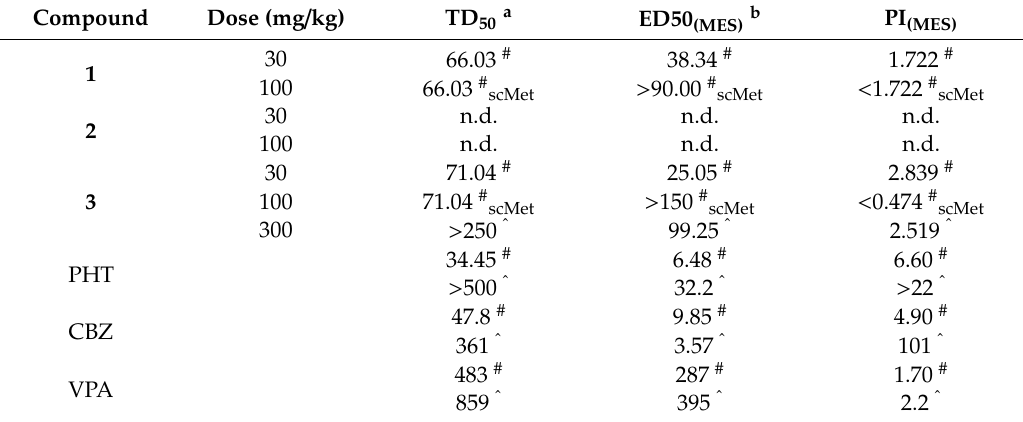
Figure 1. Chemical structures of the title compounds ( 1 – 3 ). Table 1. Anticonvulsant quantification results (in vivo study)